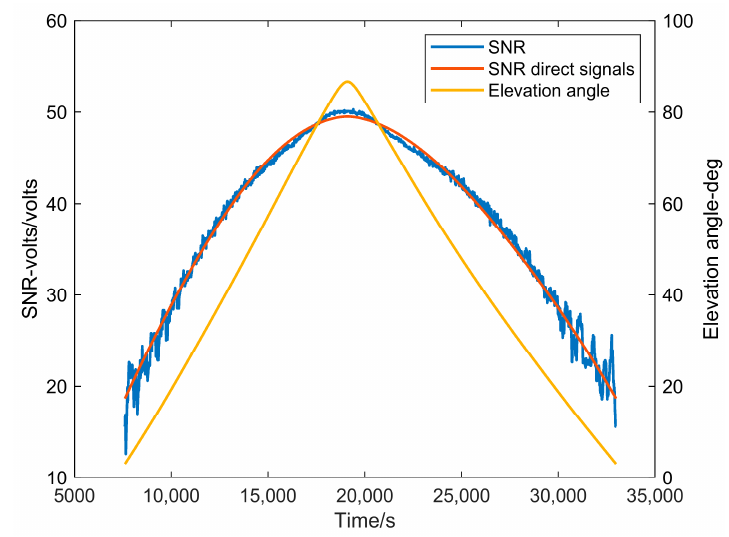
Figure 2. The SNR diagram of GPS PRN02.